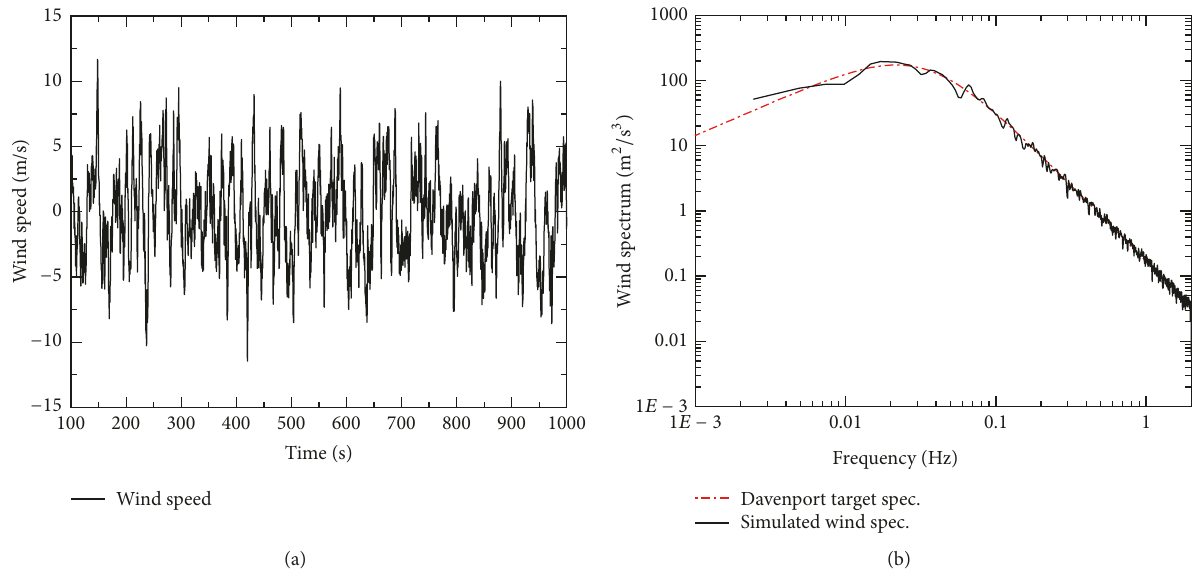
Figure 6: Simulated fluctuating wind time history: (a) wind speed and (b) power spectrum.